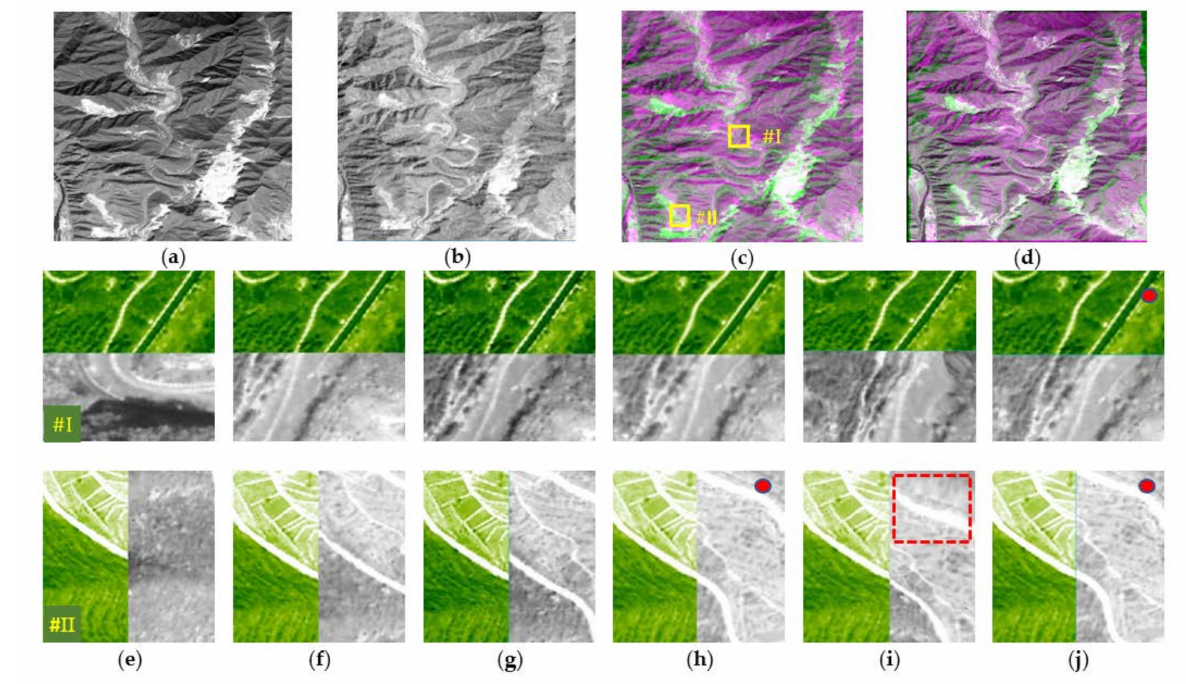
Figure 14. Registration results of image pairs in the mine treatment area. ( a ) Reference image (3900 × 4000 pixels). ( b ) Sensed image (3900 × 4000 pixels). ( c ) The overlap of the original images (shown in pseudo color). ( d ) The overlap of the reference image and the result of the proposed algorithm. Magnified images (180 × 180 pixels) from ( e ) the original images, ( f ) RRM, ( g ) PLM, ( h ) APAP, ( i ) OFM, and ( j ) the CCFR